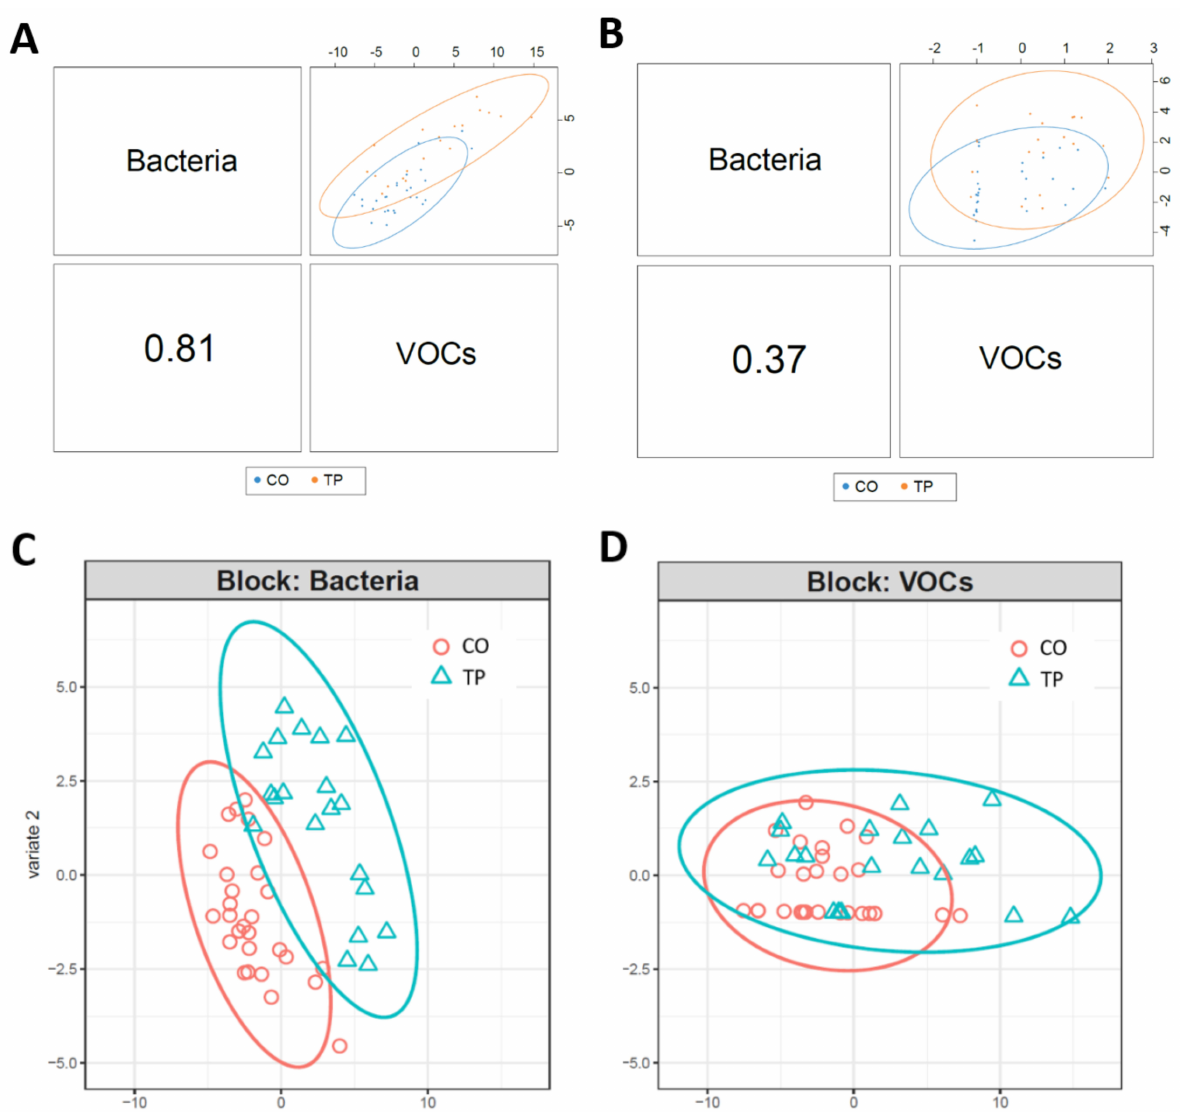
Figure 5. A Pearson’s correlation plot of bacteria and volatile organic compound (VOC) data of the colonic contents of horses infected with Anoplocephala perfoliata and non-infected controls. Component 1 is shown in ( A ) and component 2 is shown in ( B ). The ability of the model to separate CO and TP by bacteria alone is demonstrated by plot ( C ), and VOCs alone by plot ( D ). Key: TP = tapeworm positive (n = 20), CO = control (tapeworm negative, n =